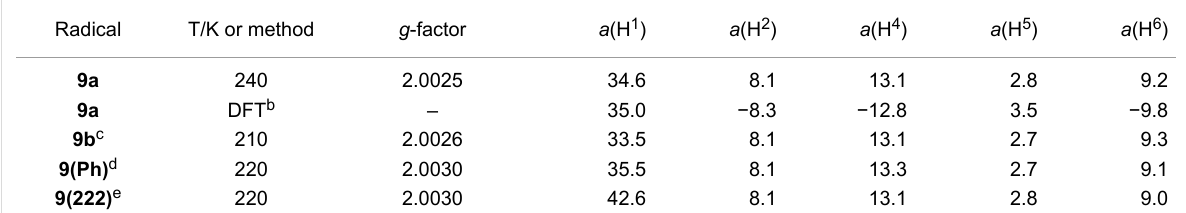
Table 1: EPR parameters of cyclohexadienyl radicals 9 from meta - additions to t -BuPh a .